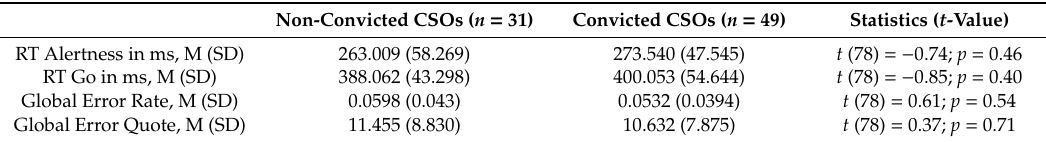
Table 2. Inhibited response to no-go trials for both groups.